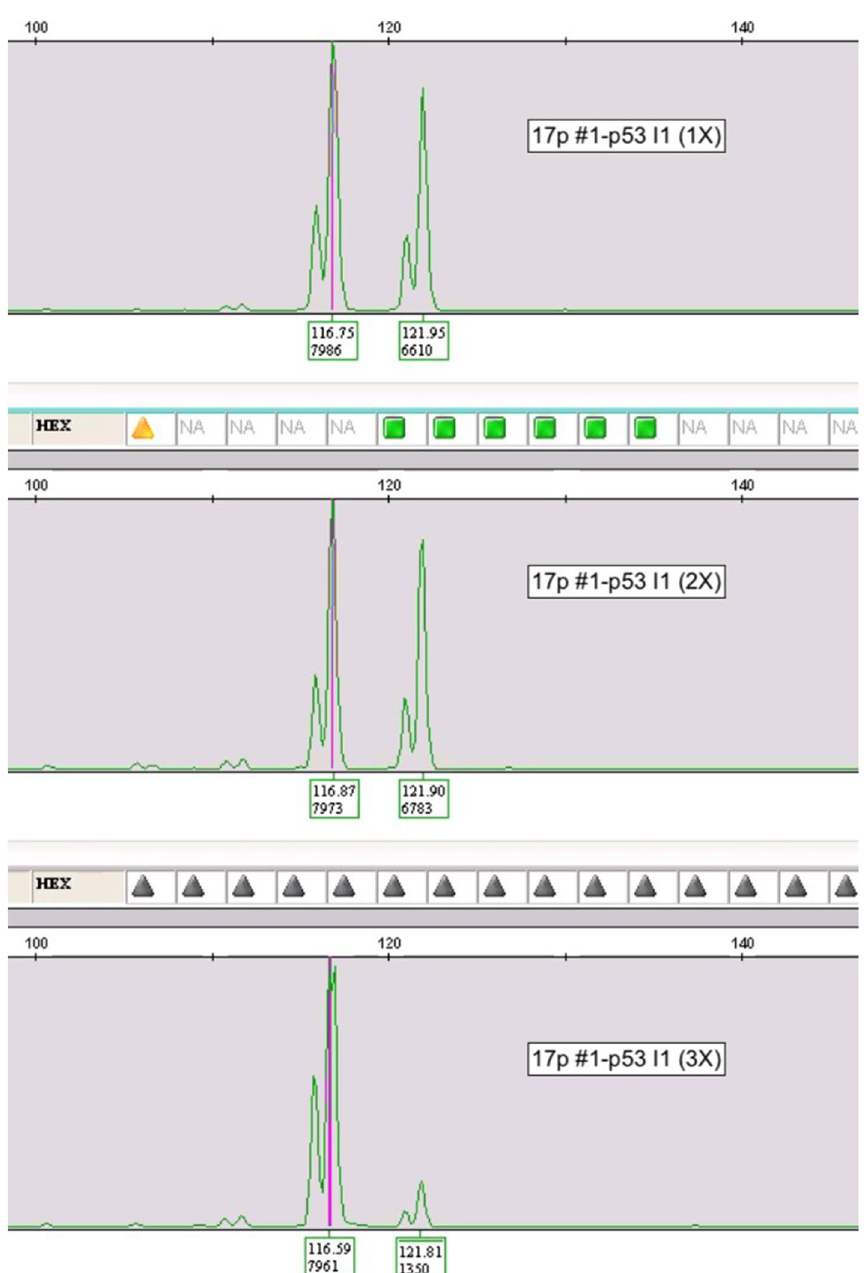
Fig. 3 Example of LOH in MSO. TP53 intron 1 pentanucleotide microsatellite. Top- non‑papillary thyroid cancer struma ovarii target. Middle- Thyroid gland microcarcinoma. Bottom- Papillary thyroid carcinoma in struma ovarii showing major loss of the larger polymorphic